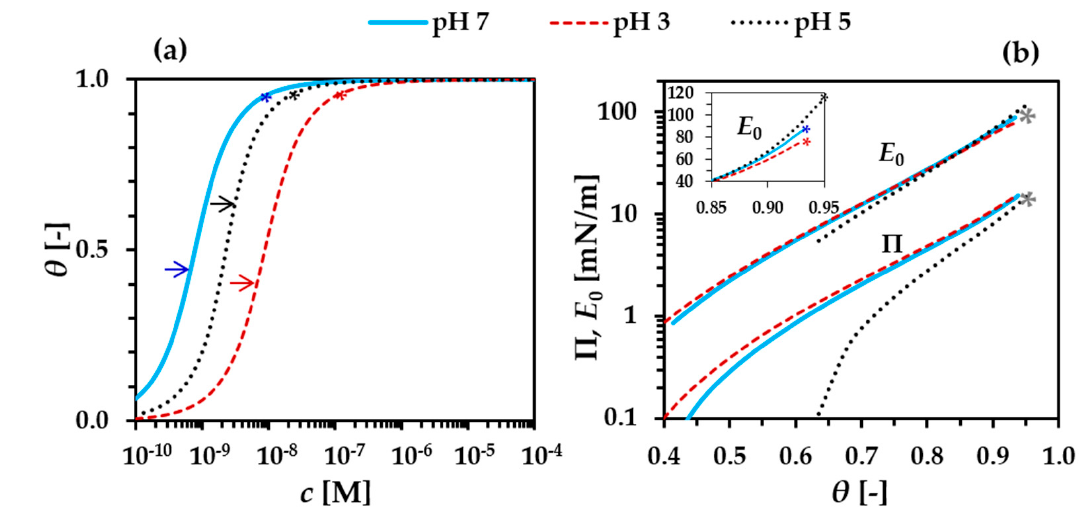
Figure 3. BLG adsorption layers at the water/air interface at different bulk pH. Computed dependencies from m2-fits: ( a ) adsorption isotherm θ ( c ), according to Equations (1)–(7); ( b ) equation of state in terms of Π ( θ ) and E 0 ( θ ) for the precritical region, according to Equations (1)–(9); note the log-scale of the ordinate. Asterisks indicate c *, Π *, θ * and E 0 *; arrows in ( a ) indicate θ Π =0.1 ; inset in ( b ) is a zoomed-in segment of the E 0 ( θ ) graph; note the linear-scale of the ordinate.